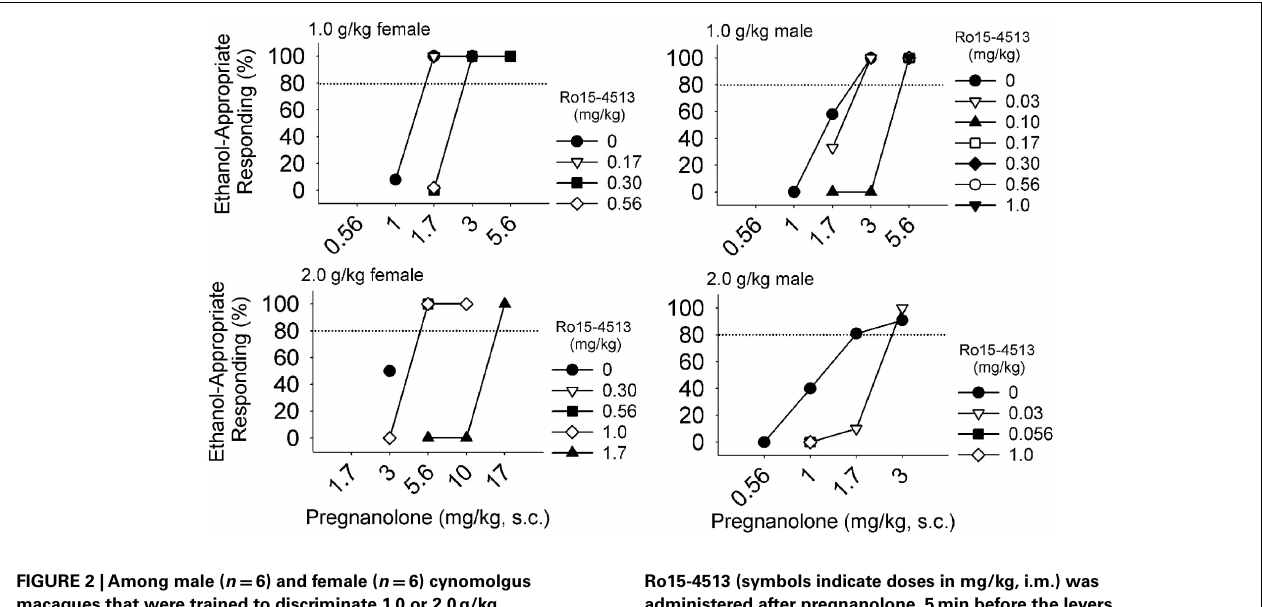
FIGURE 2 |Among male ( n = 6) and female ( n = 6) cynomolgus macaques that were trained to discriminate 1.0 or 2.0g/kg ethanol, pregnanolone produced ethanol-like discriminative stimulus effects in all monkeys, which were antagonized when